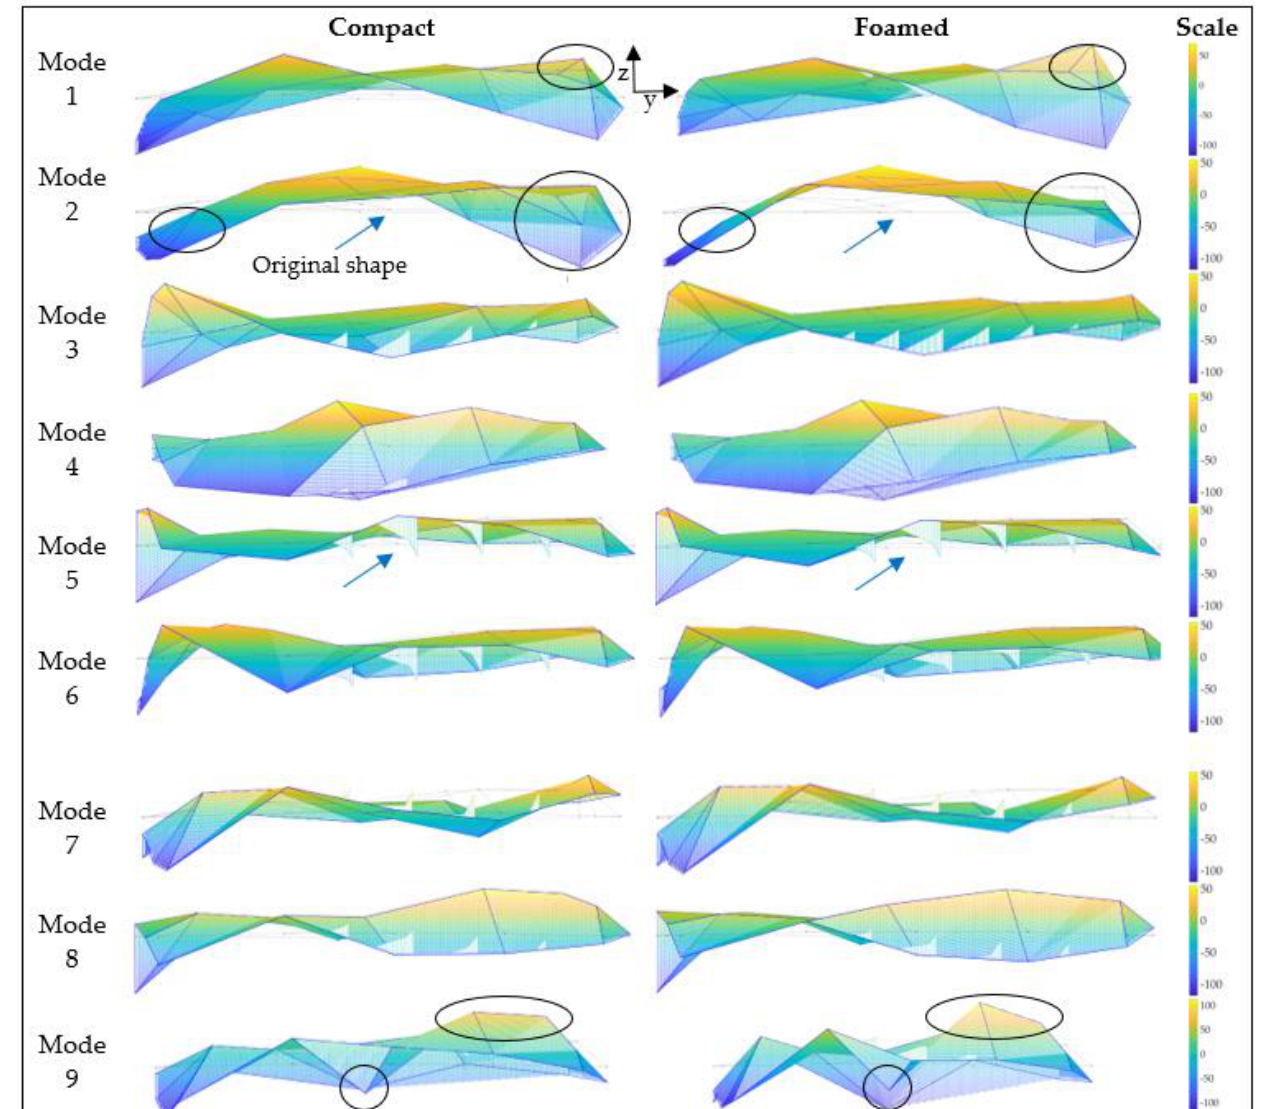
Figure 23. Plate mode shapes for compact and foamed door panels. Dotted lines represent the undeformed wireframe of the panel (indicated by arrows). Circles highlight local differences in deflection. Lined triangles jutting from the part are caused by the employed surface color visualization method.